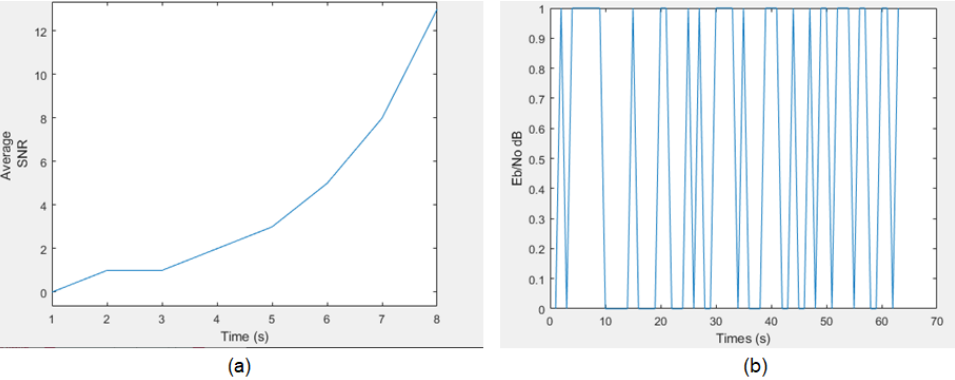
Figure 6. Noise measurement in a Li-Fi network. ( a ) according to modified BM, ( b ) according to BM. Figure 7 represents an example of the RS code flow for error correction: (15,11),